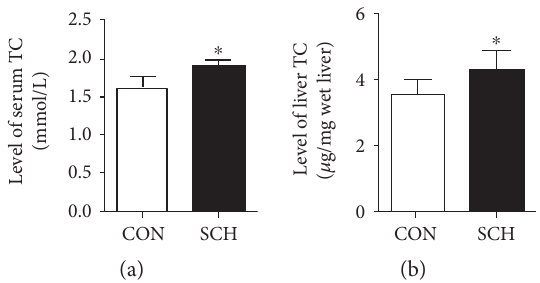
Figure 1: Serum and liver TC levels increased in SCH mice. Male Kunming mice were divided into two groups: mice in the SCH group were given 4 mg/kg · d methimazole in their drinking water; mice in the control group received an equal volume of distilled water. At the end of two months, the serum and livers of these mice were harvested for assay. Serum cholesterol levels (a) and liver tissue cholesterol contents (b) were assayed using a Cholesterol/Cholesteryl Ester Quantitation Kit. Data are representative of three independent experiments. ∗ p < 0 05 versus control